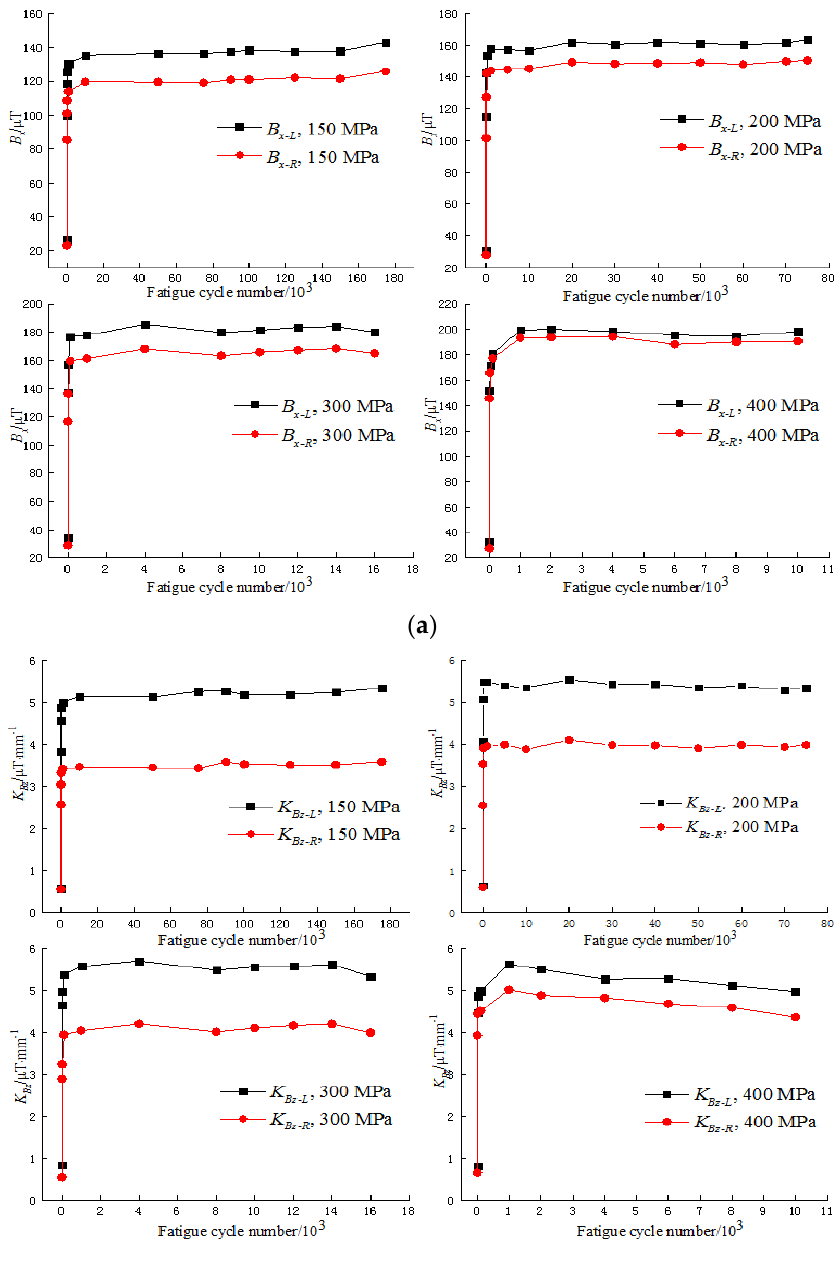
Figure 5. Characteristic variation of ( a ) B x signals and ( b ) B z signals of different specimens during the fatigue test.